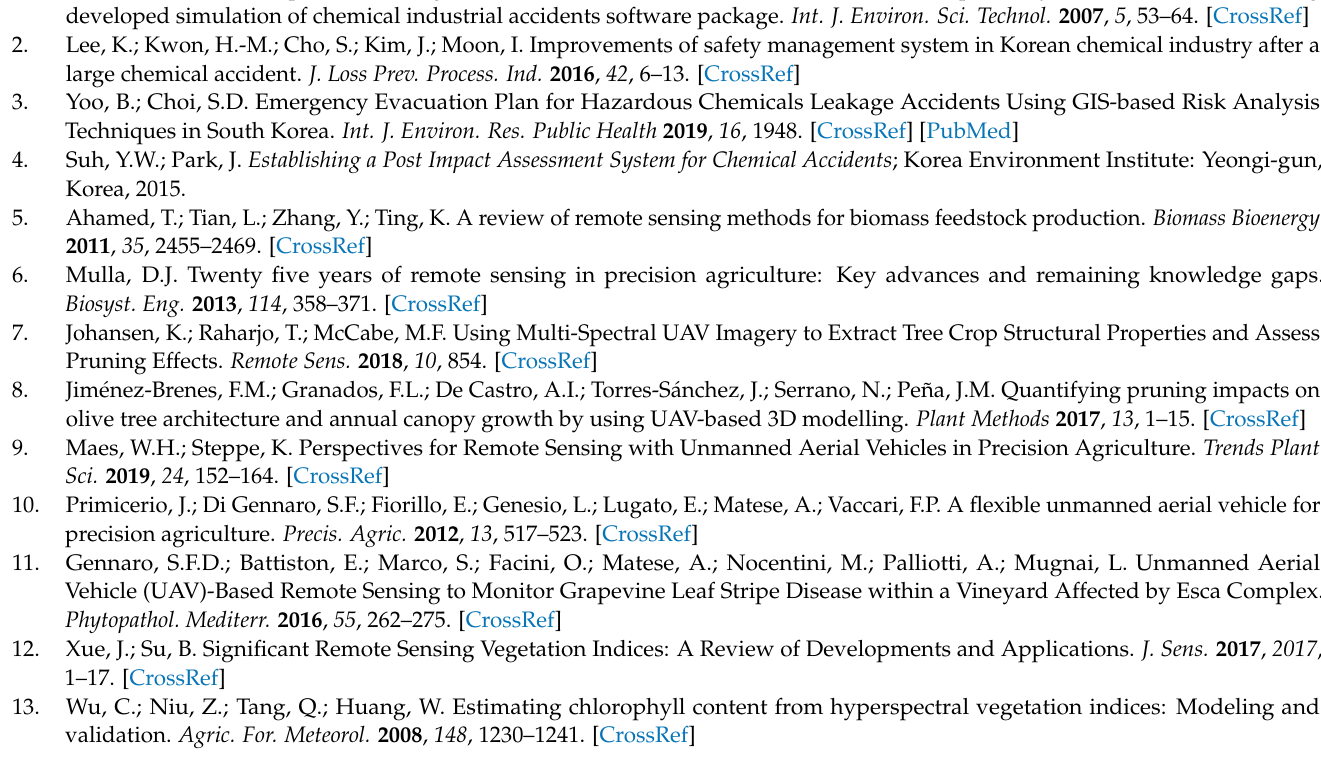
Figure A3. Correlation between chlorophyll contents measured using a microplate reader and the SPAD value. R and p refer to the Pearson correlation coefficient and p -value, respectively (* p < 0.05; ** p < 0.01; *** p < 0.001).